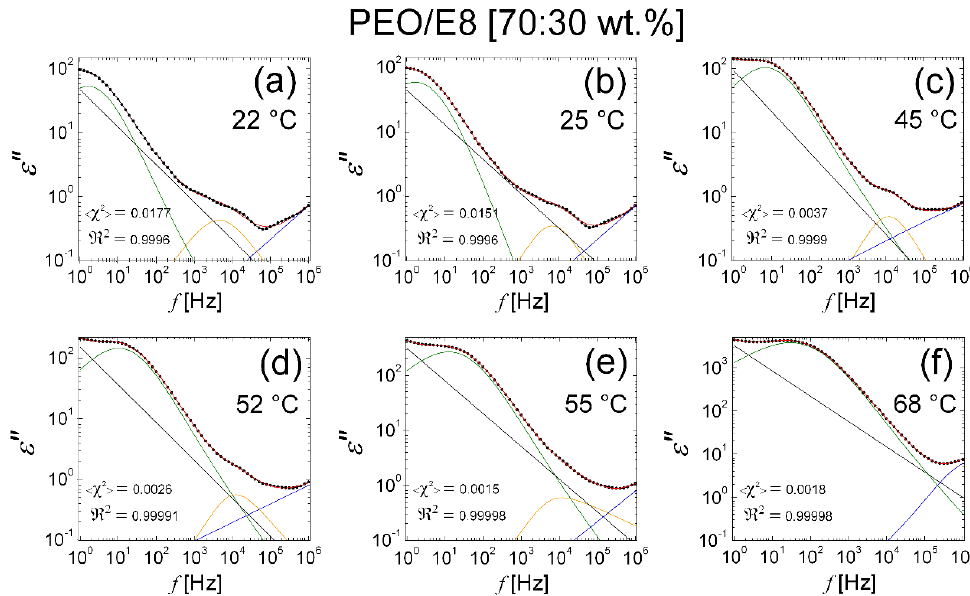
Figure 20. Fits on the ε ″ ( f ) spectra of PEO/E8 using Equation (6). The ε ″( f ) spectra correspond to temperature 22 °C ( a ); 25 °C ( b ); 45 °C ( c ); 52 °C ( d ); 55 °C ( e ); 68 °C ( f ). The ε ″ spectral data are represented by the symbol (X); the blue, the green, and the yellow lines of the best fits on the ε ″ data are the contributions of the two HN functions in the ε term and the single HN term in Equation (6), respectively; the straight line represents the contribution of the conductivity term; the envelope of the four spectral components’ curves (the total fit) is colored in red. The values of the reduced < χ 2 > factor and the regression coefficient are also shown.